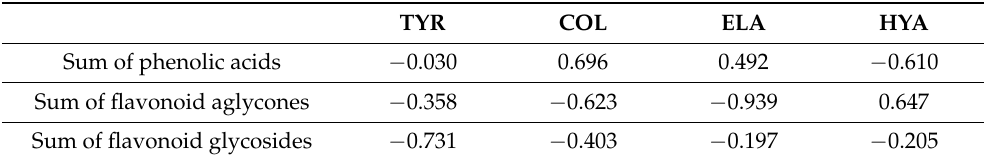
Table 8. Pearson’s correlation coefficients ( r ) between the skin ageing-related enzymes and concentra- tions of secondary metabolites in AL extracts. Abbreviations: TYR—tyrosinase; COL—collagenase; ELA—elastase; HYA—hyaluronidase